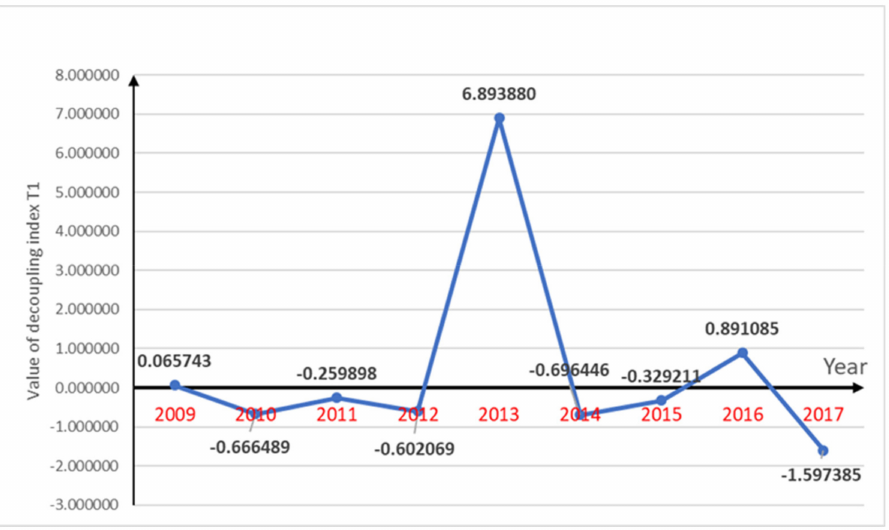
Figure 2. Decoupling index changes of T 1 along with period of year.